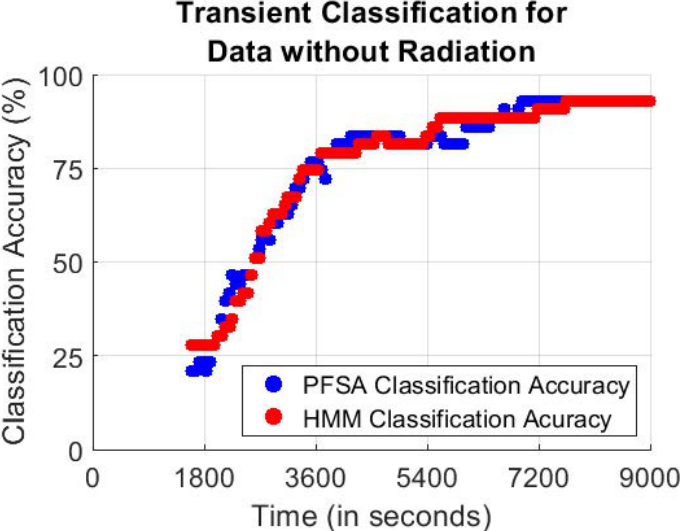
Figure 6. Transient classification accuracy over all data without radiation heat transfer for PFSA and HMM.